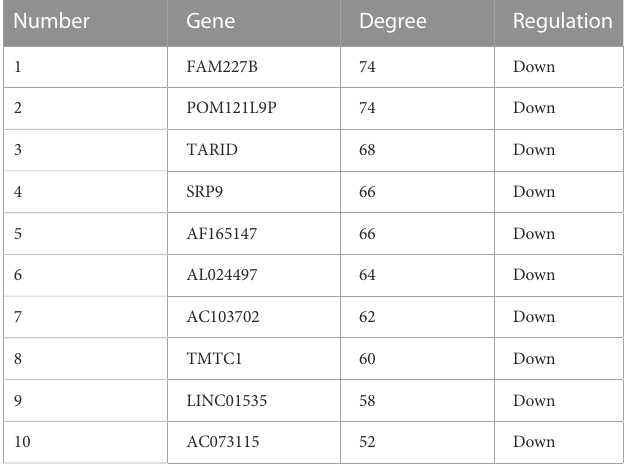
TABLE 2 The top 10 lncRNAs were sorted by connectivity